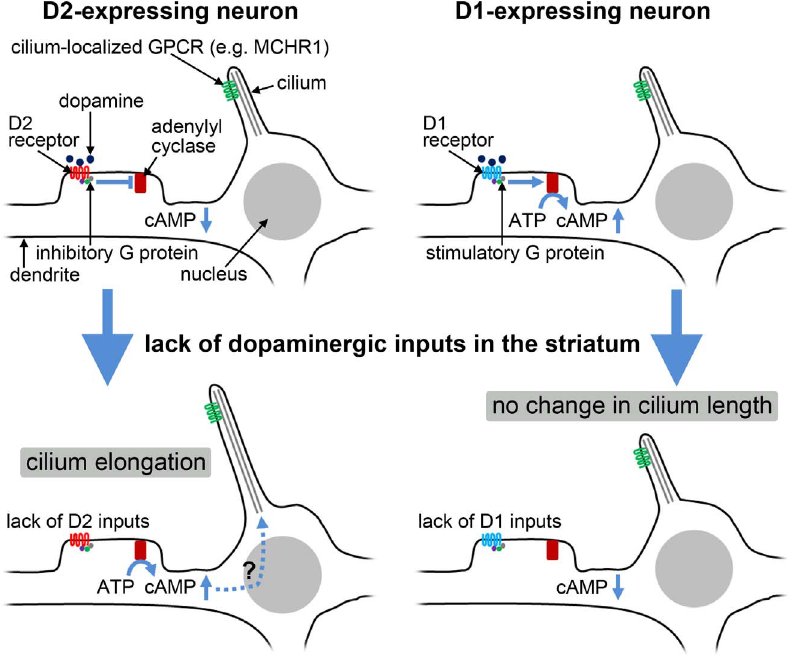
Figure 5. Schematic diagram depicting our findings on the length change of striatal neuronal cilia. It is generally accepted that dopaminergic inputs to D1 and D2 receptors activate or inactivate adenylyl cyclase-mediated generation of cAMP via stimulatory or inhibitory G proteins, respectively. A lack of D1 inputs, which had been expected to decrease the cAMP level, had no effect on the length of neuronal cilia. On the other hand, a lack of D2 inputs, which had been expected to increase the cAMP level, elongated neuronal cilia. Besschetnova et al. demonstrated that cAMP levels positively regulate the length of primary cilia in cultured cells [28], while our results suggest that the alteration of cAMP levels is not likely to fully account for the length change of striatal neuronal